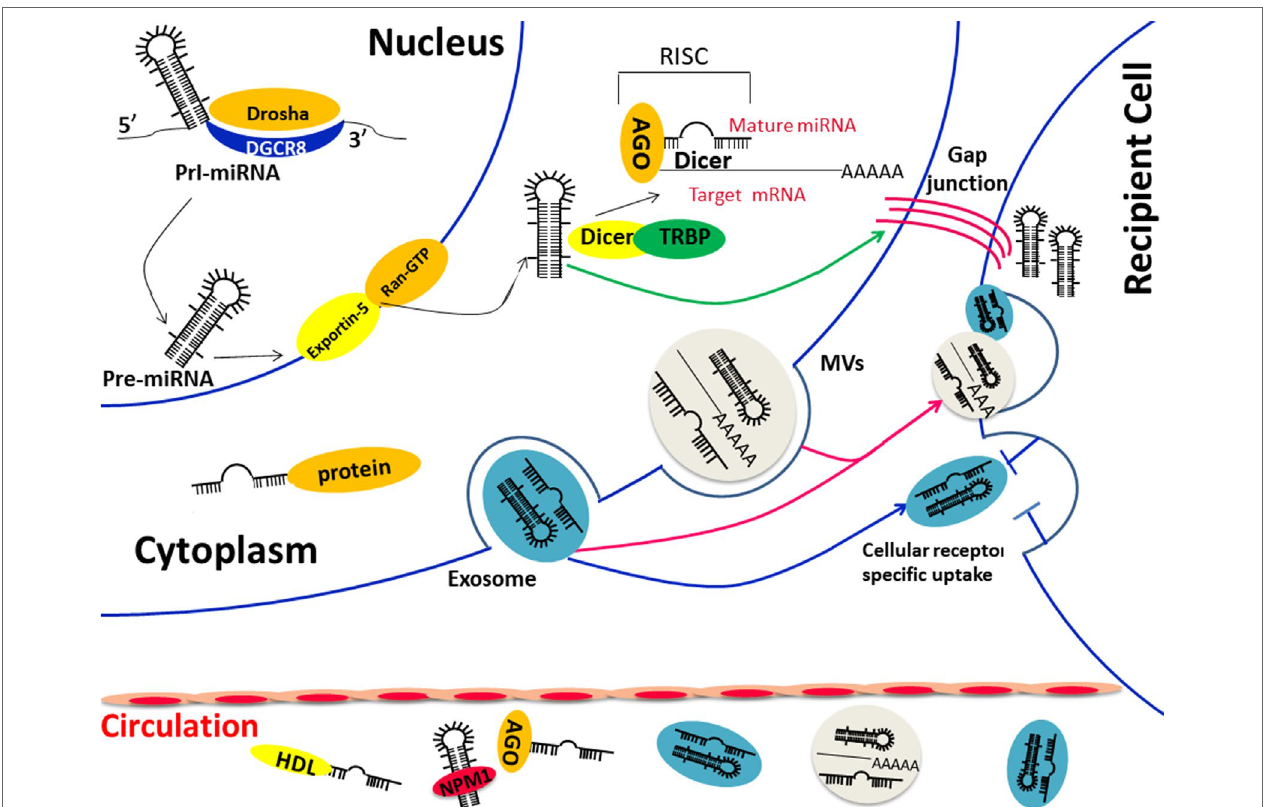
FIGURE 1 | (1) Biological functions and transportation carriers of circulating miRNA; (2) Diverse ways of miRNAs in cell communication: direct fusion and endocytosis of extracellular vesicles (exosomes orMVs) (red arrow) or direct transfer through cell gap junction (green arrow) or the indirect identification of specific surface receptor (blue arrow). Abbreviations: Pre-miRNA, precursor miRNA; Pri-miRNA, primary miRNA; AGO, Argonaute; TRBP, transactivation-responsive RNA- binding protein; DGCR8, DiGeorge Syndrome Critical Region Gene 8; MVBs, multivesicular bodies; NPM1, nucleophosmin